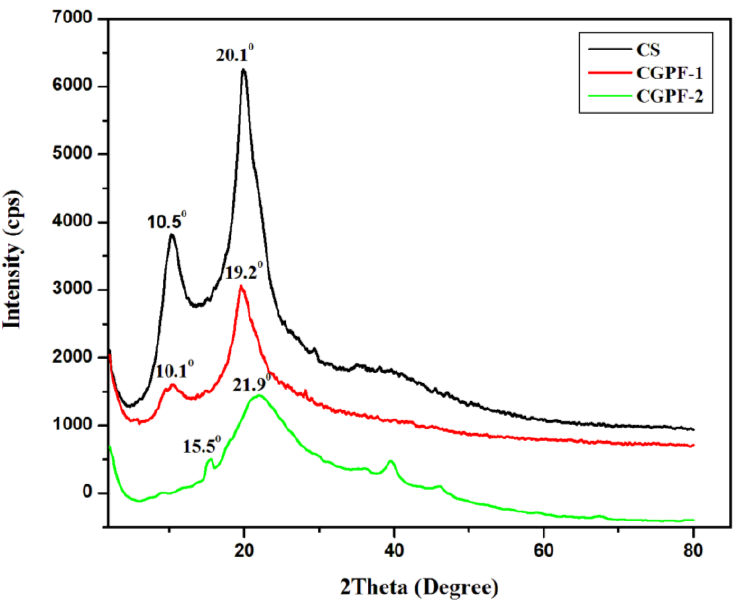
Figure 4. X-ray diffraction spectra of chitosan, grafted chitosan, and grafted chitosan–Pt–Fe 3 O 4 nanoparticles nanocomposite films.